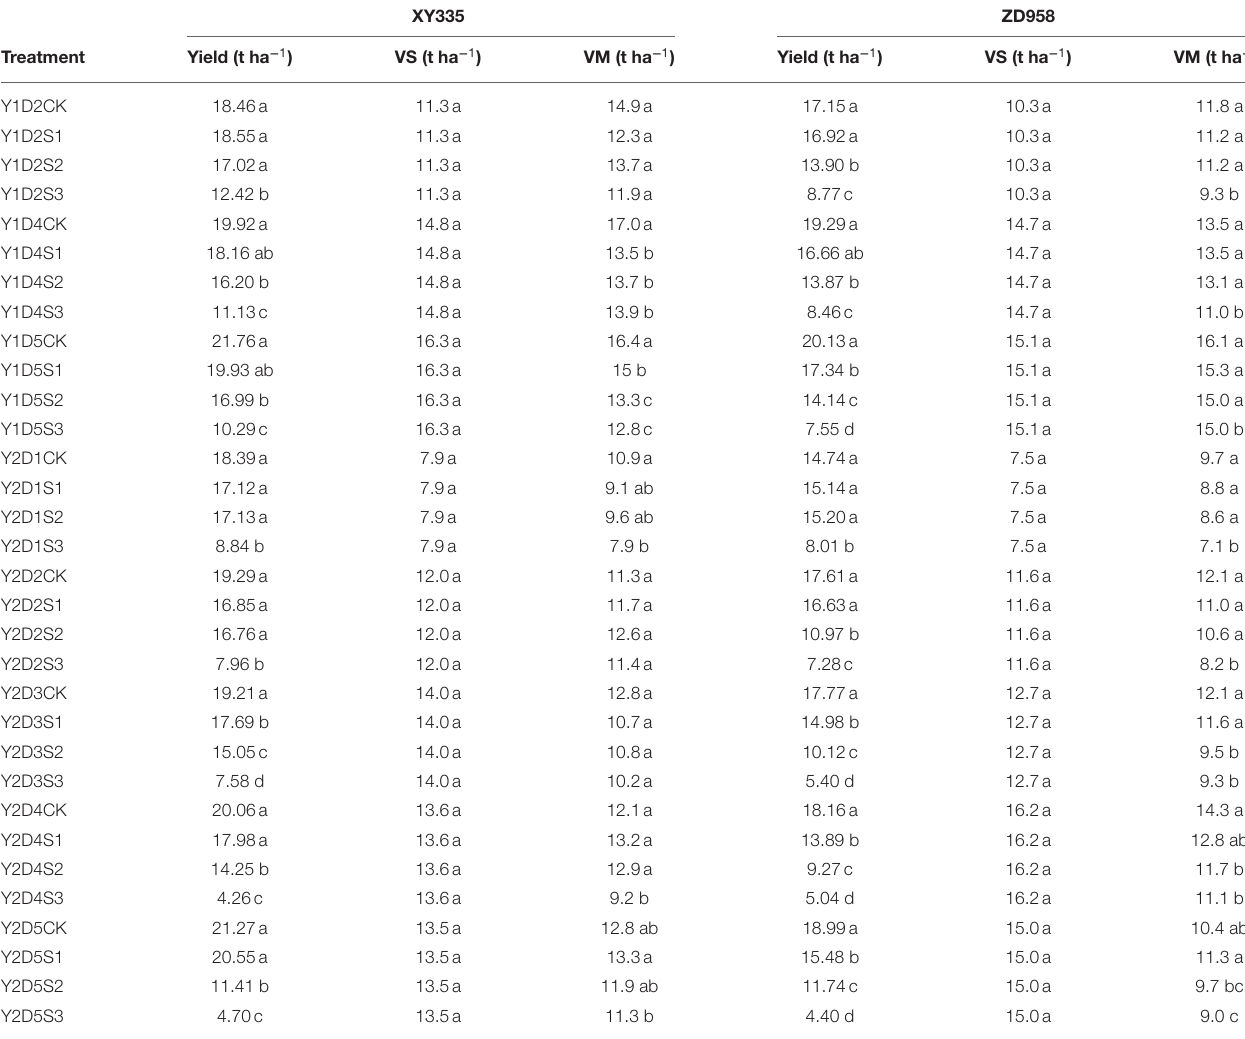
TABLE 1 | Effects of different shading levels (CK, natural light; S1, 15% natural light; S2, 30% natural light; S3, 50% natural light) and planting densities (D1, 4.5 × 10 4 plants ha − 1 ; D2, 7.5 × 10 4 plants ha − 1 ; D3, 9 × 10 4 plants ha − 1 ; D4: 10.5 × 10 4 plants ha − 1 ; D5, 12 × 10 4 plants ha − 1 ) on maize grain yields and dry weights of plant organs (dry matter of vegetative organs at silking [VS] and at maturity [VM]) in 2017 (Y1) and 2018